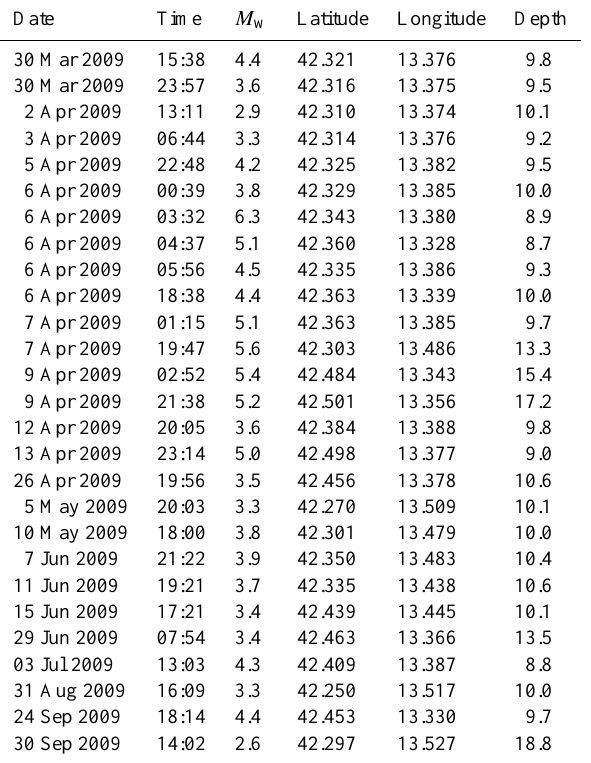
Table 1. The earthquake sequence list, time in LT and depth in